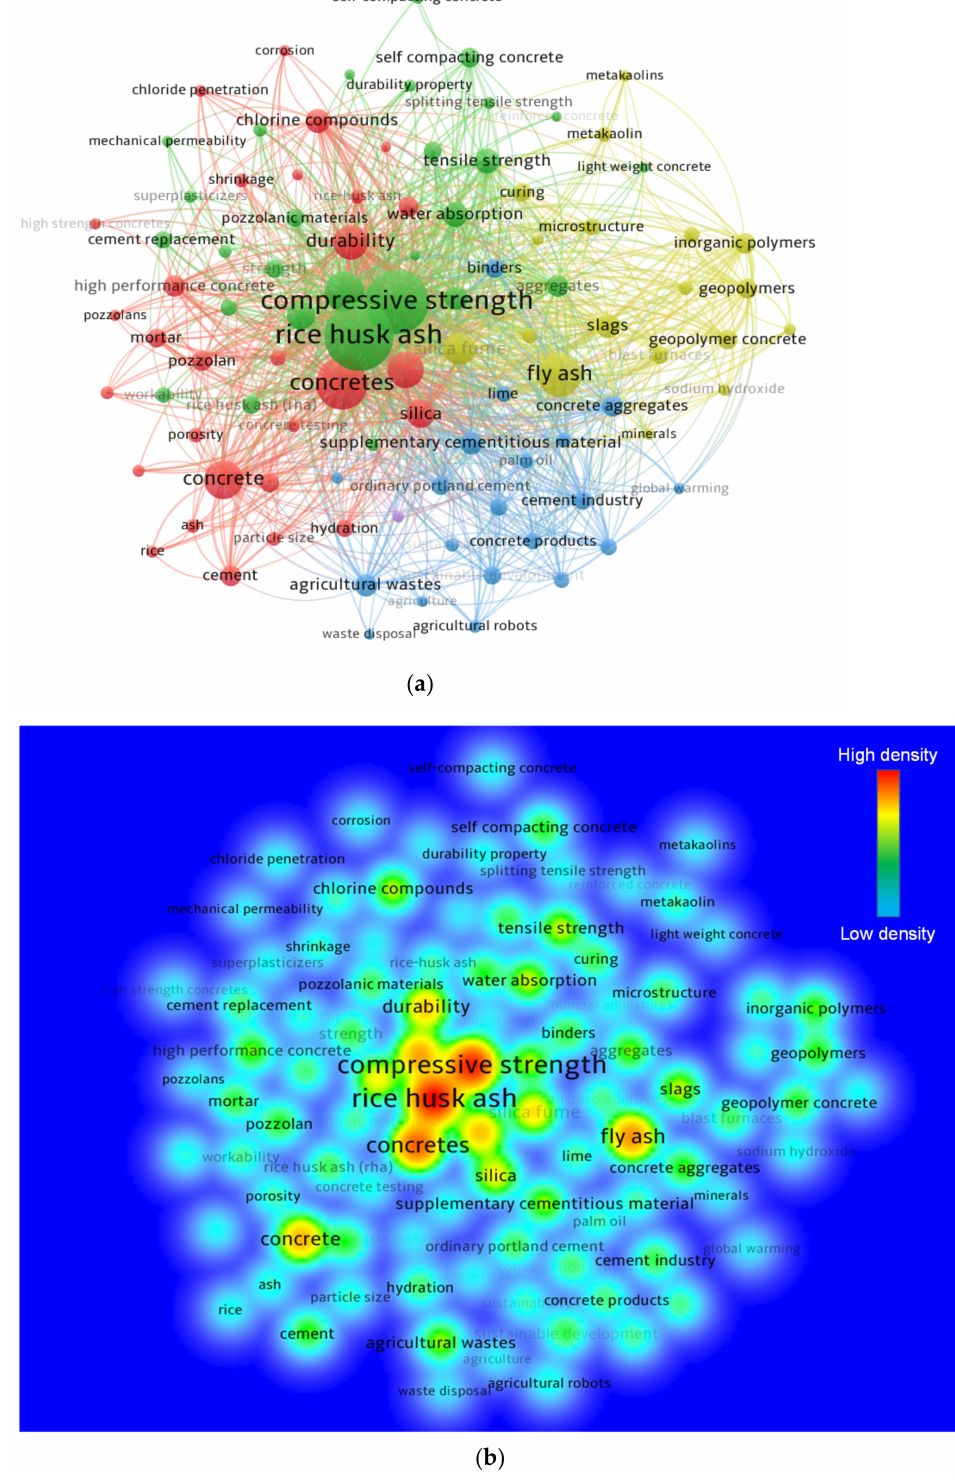
Figure 7. Keywords analysis: ( a ) scientific visualization; ( b ) density